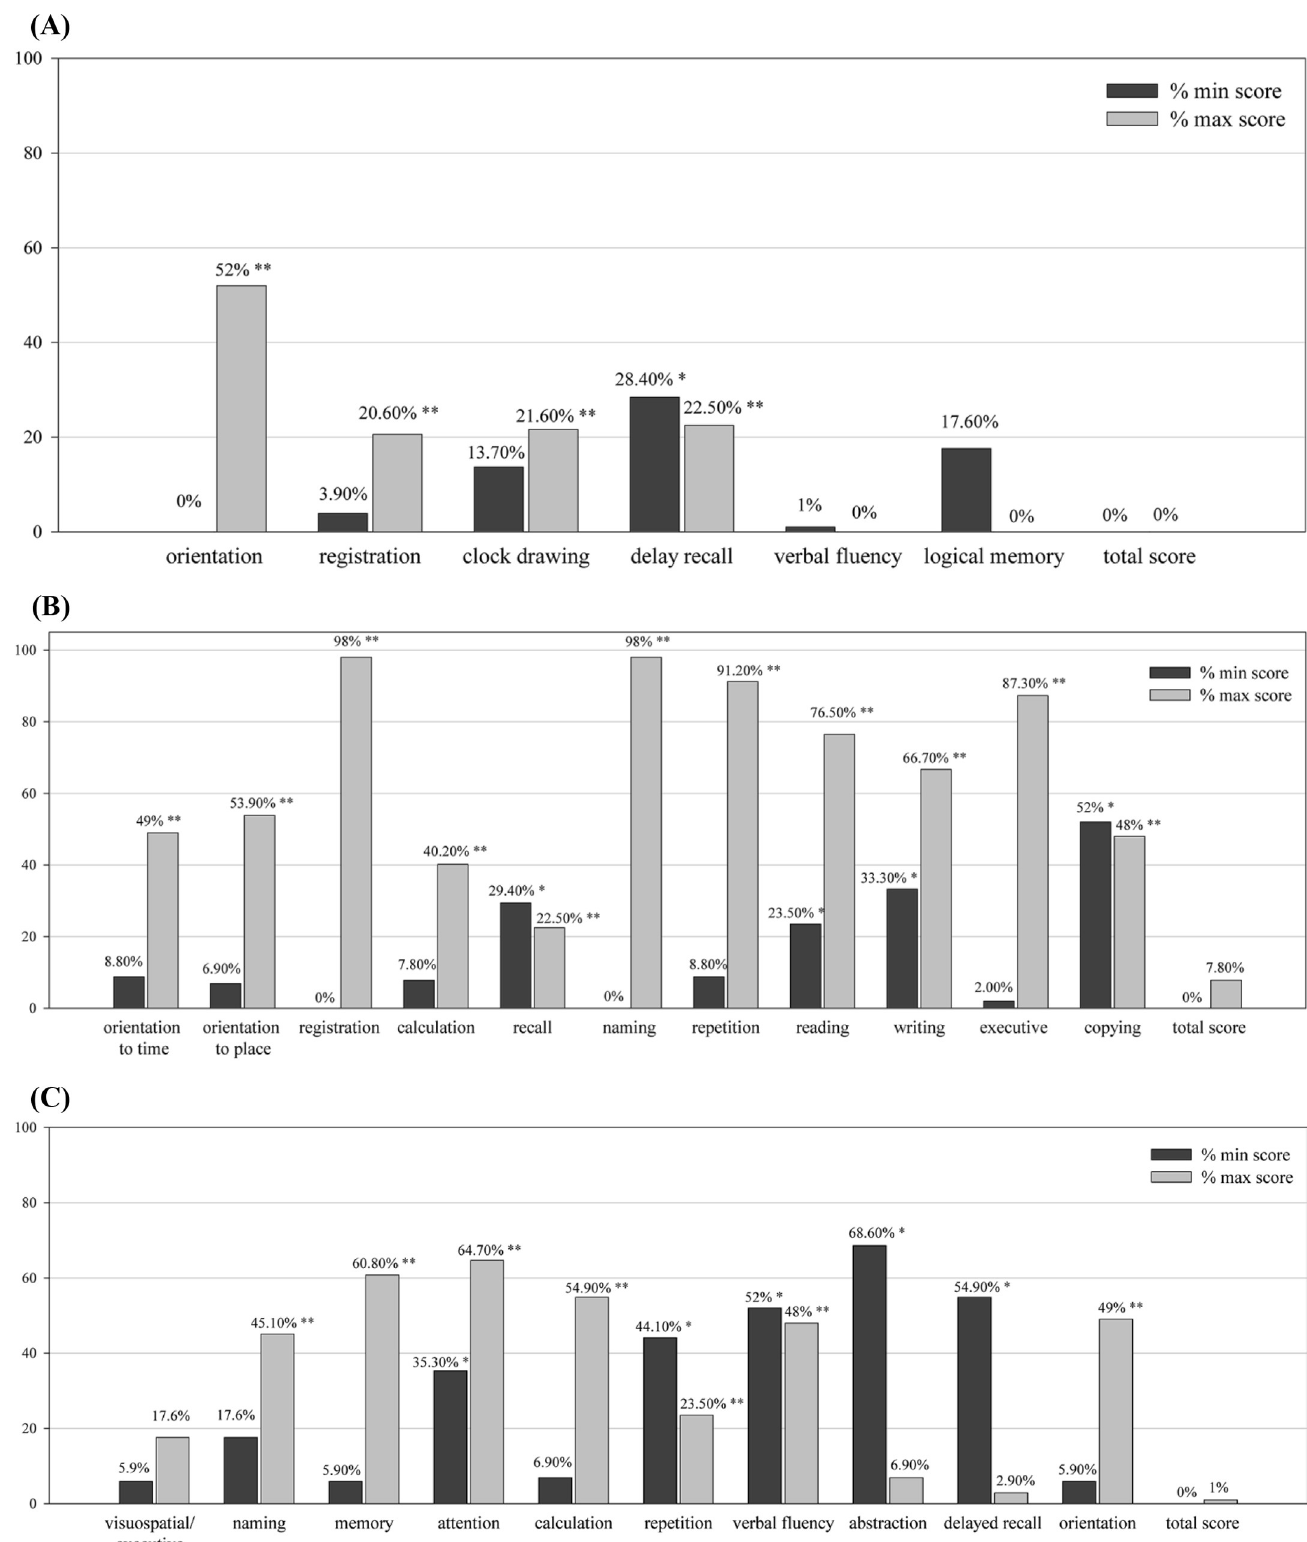
Fig 1. Percentage of minimum and maximum scores on total and subtests of the (A) Q mci -TW, (B) MMSE, and (C) MoCA. � � 20% of patients obtained minimum scores. �� � 20% of patients obtained maximum scores. https://doi.org/10.1371/journal.pone.0207851.g001 PLOS ONE | https://doi.org/10.1371/journal.pone.0207851 December3,